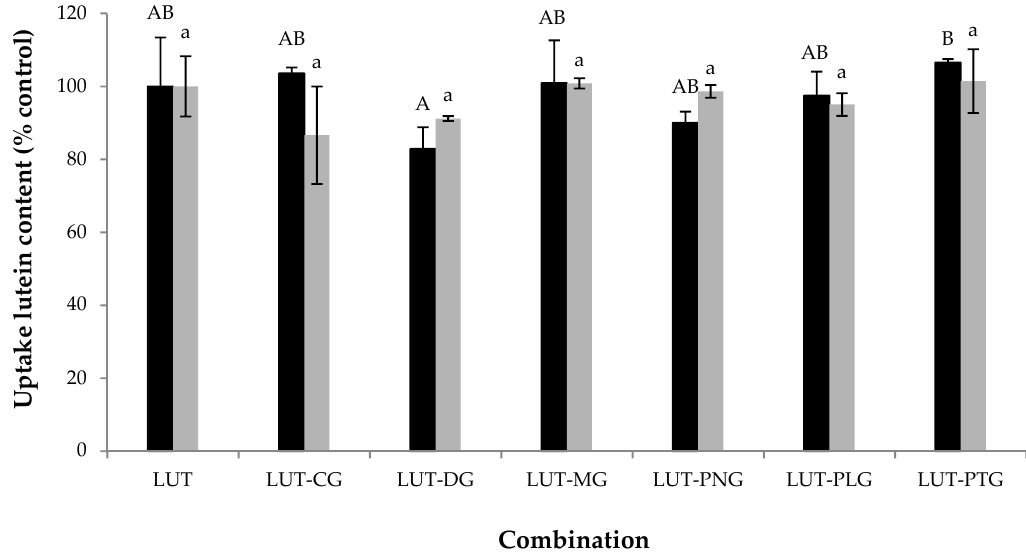
Figure 4. Lutein uptake (% control) by Caco-2 cells in the absence (control) and presence of different anthocyanins at lutein:anthocyanin ratios of 1:3 (2.5:7.5 µ M, represented in black bars) and 1:1 (5:5 µ M, represented in grey bars). Columns of the same colour marked with different letters indicate a significant difference from each other ( p < 0.05). Values are mean ± SD of three independent replicates. LUT: lutein, CG: kuromanin chloride, DG: myrtillin chloride, MG: oenin chloride, PNG: peonidin-3-glucoside chloride, PLG: callistephin chloride, PTG: petunidin-3-glucoside chloride .